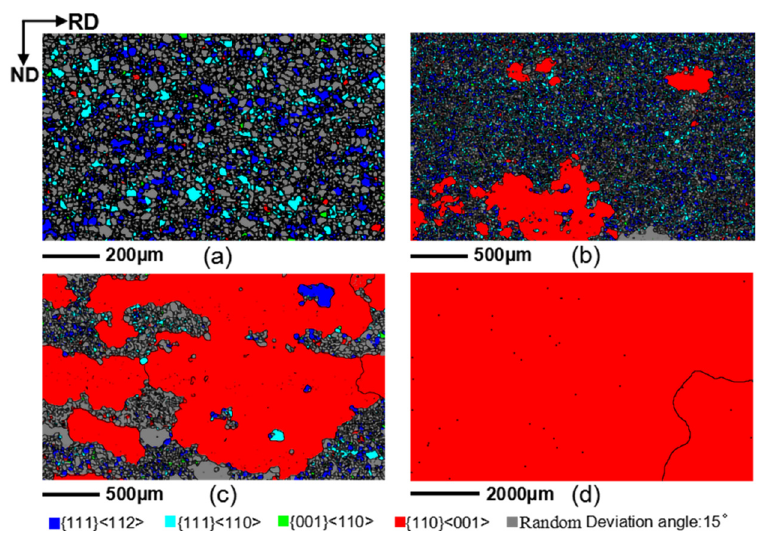
Figure 7. Orientation image maps of Fe 81 Ga 19 thin sheets along the surface section heated to different annealing temperatures: ( a ) 825 °C, ( b ) 850 °C, ( c ) 900 °C, and ( d ) 950 °C.